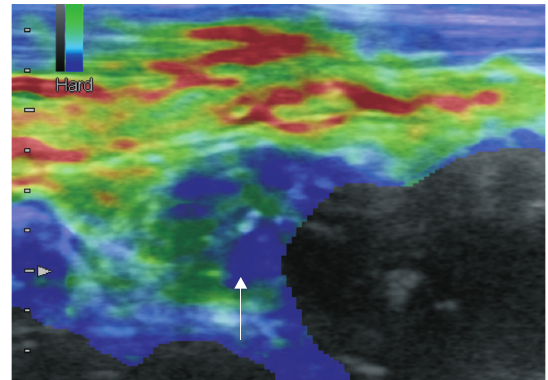
Figure 4 Most area of the nodule appears in blue on real-time elastography.